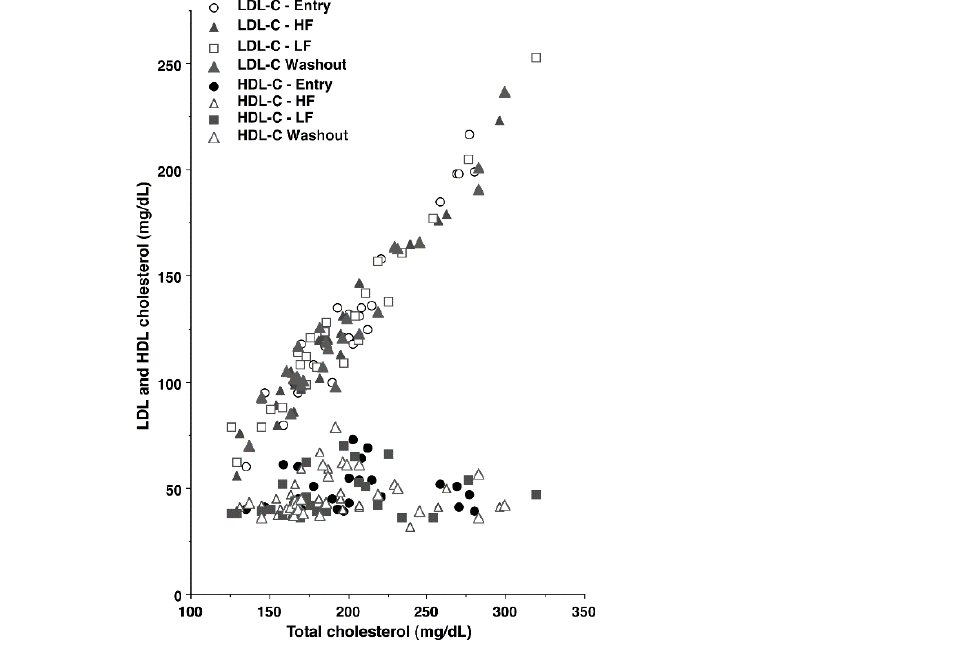
Figure 2. Plasma LDL-C and HDL-C concentrations as a function of plasma total cholesterol concentration. LDL-C, r 2 = 0.947; HDL-C, r 2 = 0.022.